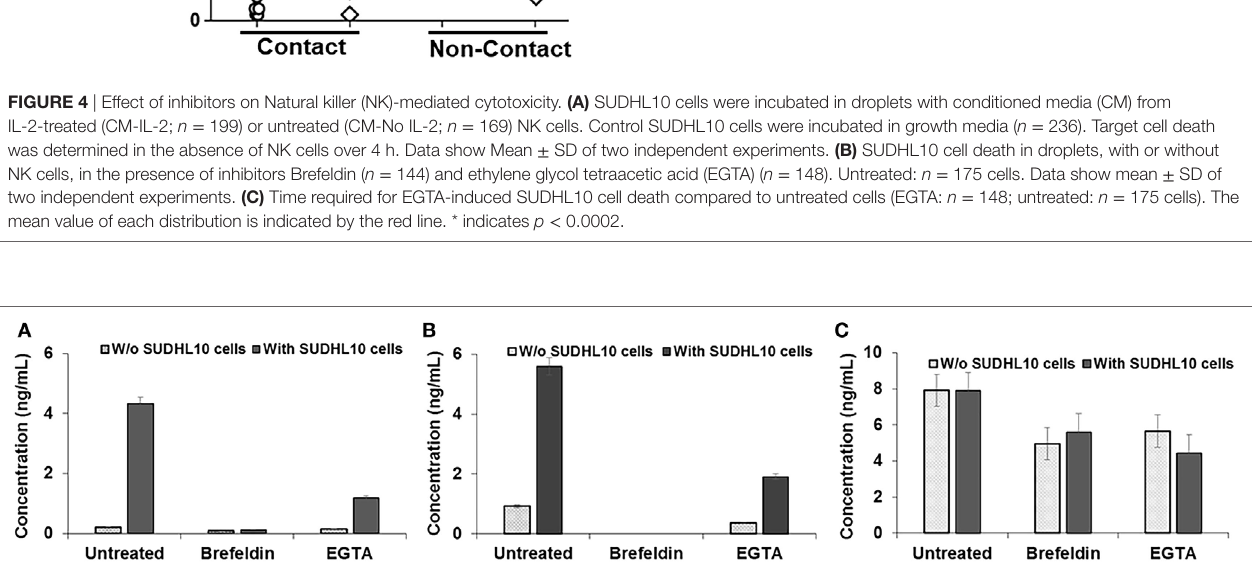
FigUre 5 | Cytokine secretion by natural killer (NK) cells. (a) IFN- γ , (B) TNF- α , and (c) Perforin secretion by NK cells, cocultured with or without target SUDHL10 cells, in the presence of inhibitors Brefeldin and EGTA. Mean ± SD of three replicates.